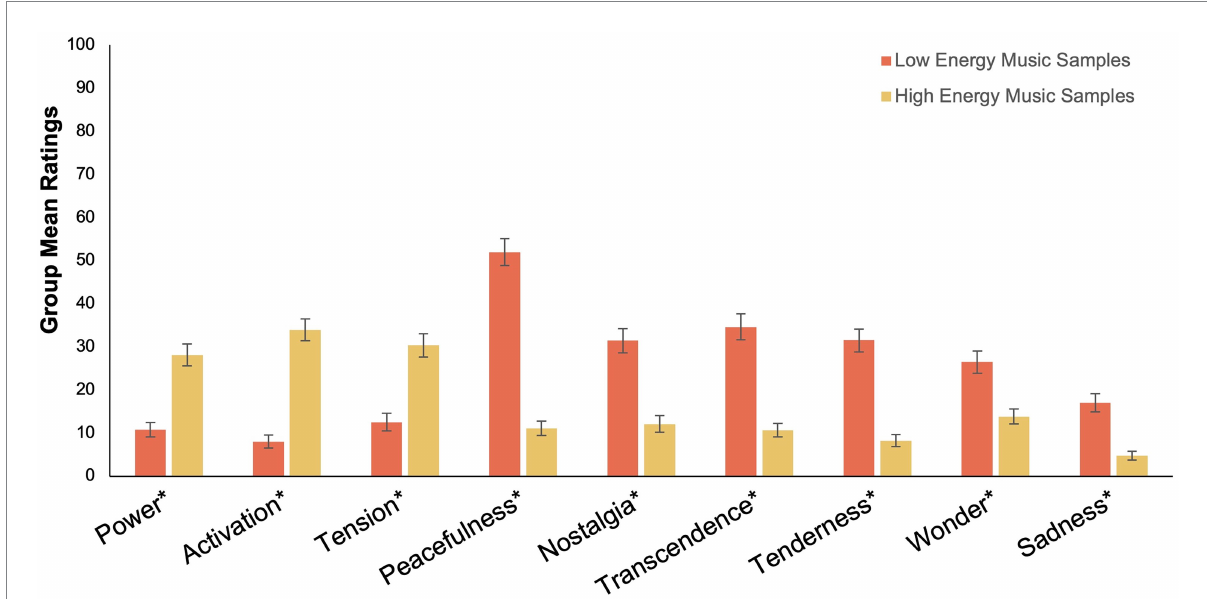
FIGURE 3 Group Mean Ratings for Emotional Responses For High Energy and Low Energy Music. This graph illustrates that chronic pain patients had significantly different emotional responses to high energy music compared to low energy music. Emotional ratings were provided on an amended version of the Short version of the Geneva Emotional Musical Scale (GEMS-9), using a scale of 1–100. The y -axis indicates the possible range of scores from 1 to 100. Error bars denote one standard error around the mean. Comparisons between the group mean scores of emotional responses were made using paired t-tests. *Significant at the 0.001 alpha